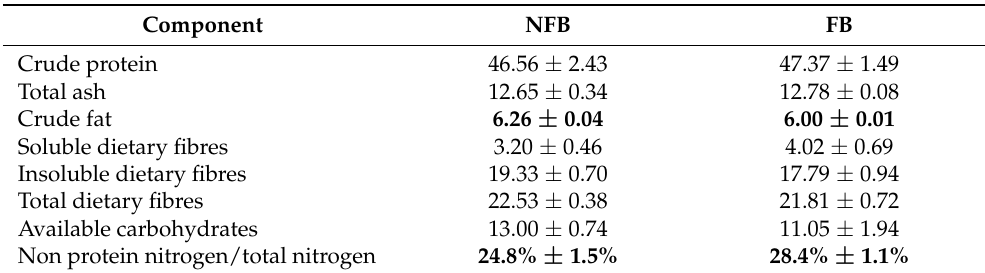
Table 2. Nutritional composition of non-fermented (NFB) and fermented A. platensis broth (FB). Values are expressed as percentage of dry weight. Data represent mean values ± SD.